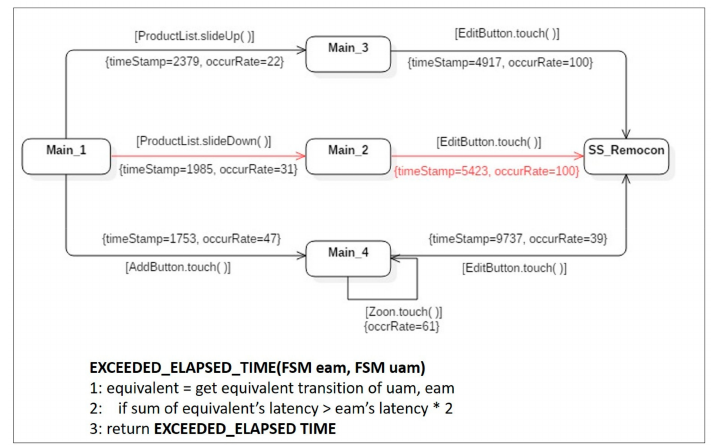
Figure 11. An instance of a user activity model, including bad symptom type